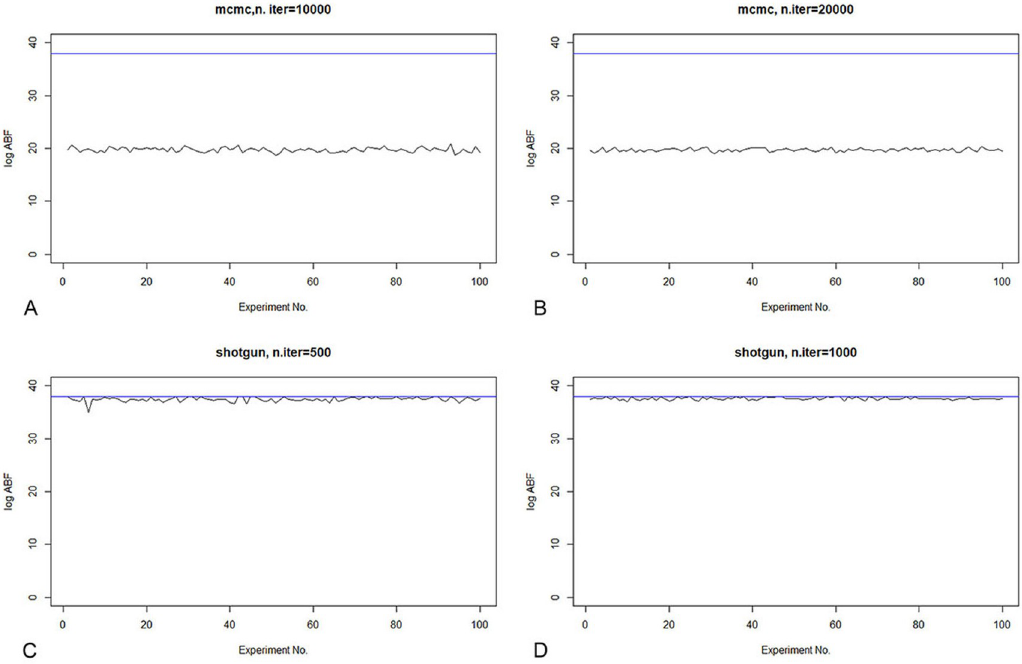
Fig 4. The comparison in stability of MCMC and